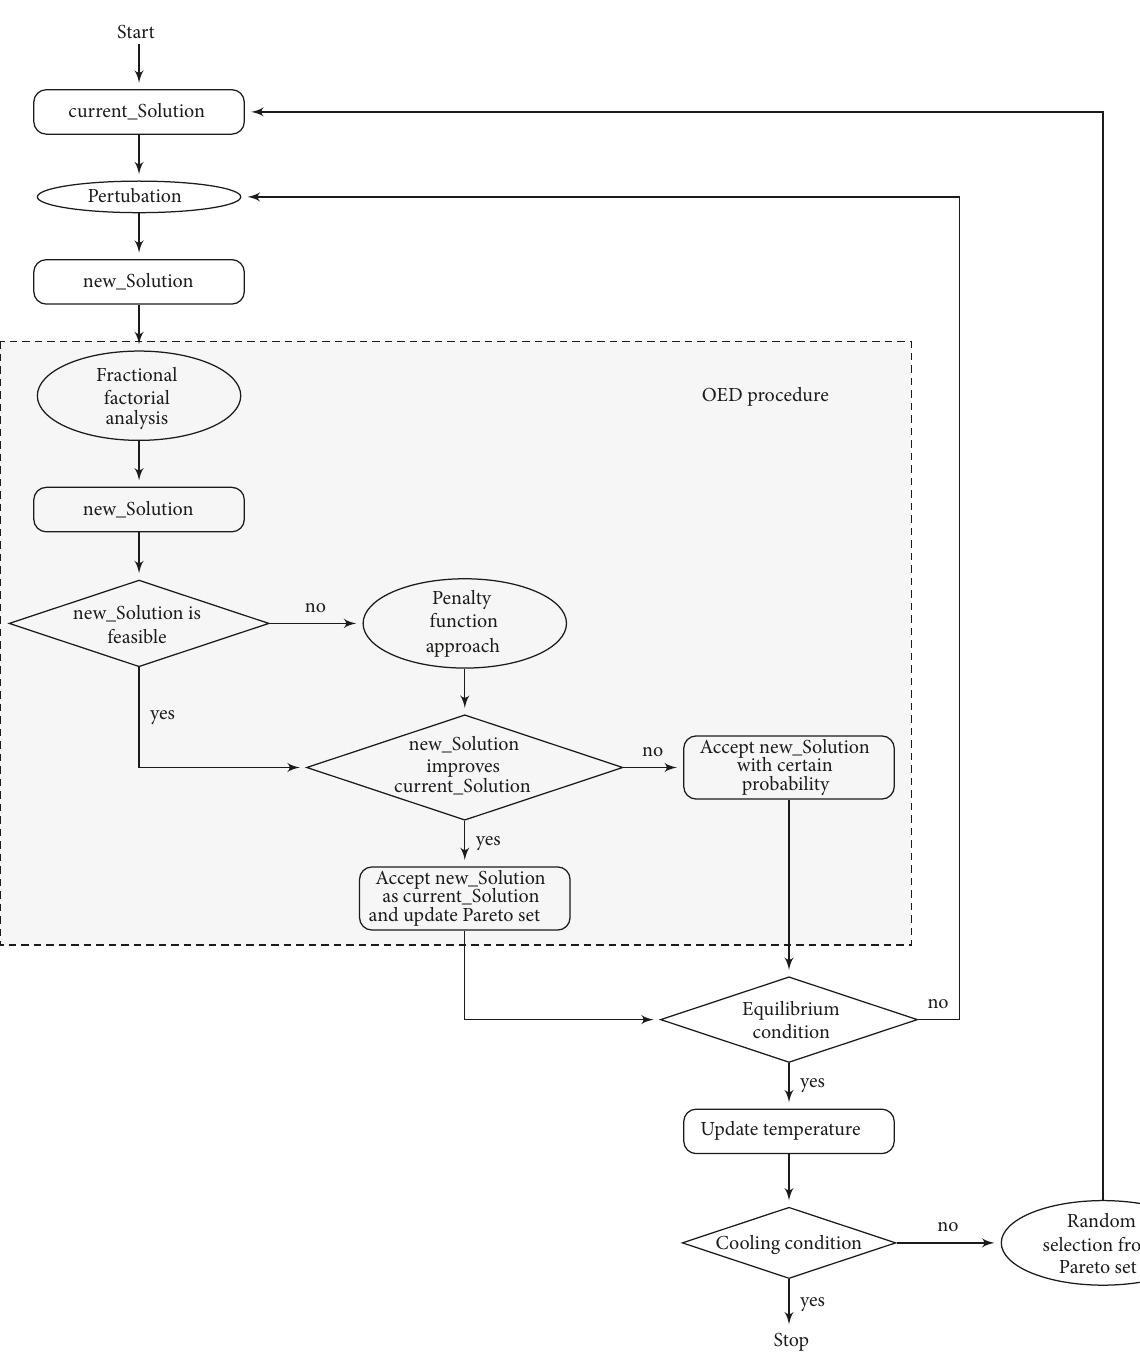
Figure 5: Orthogonal simulated annealing